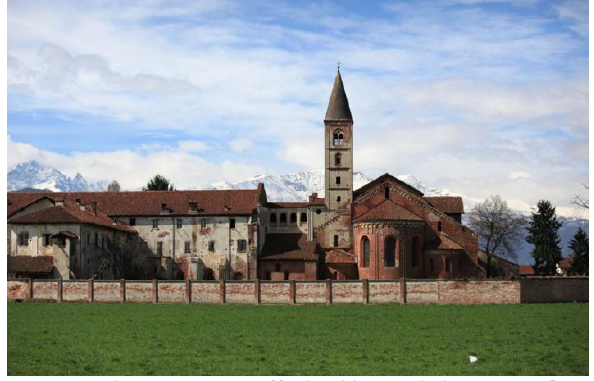
Figure 1. The Cistercian Staffarda Abbey with the snowy Alps in the background. (CN) Piedmont –